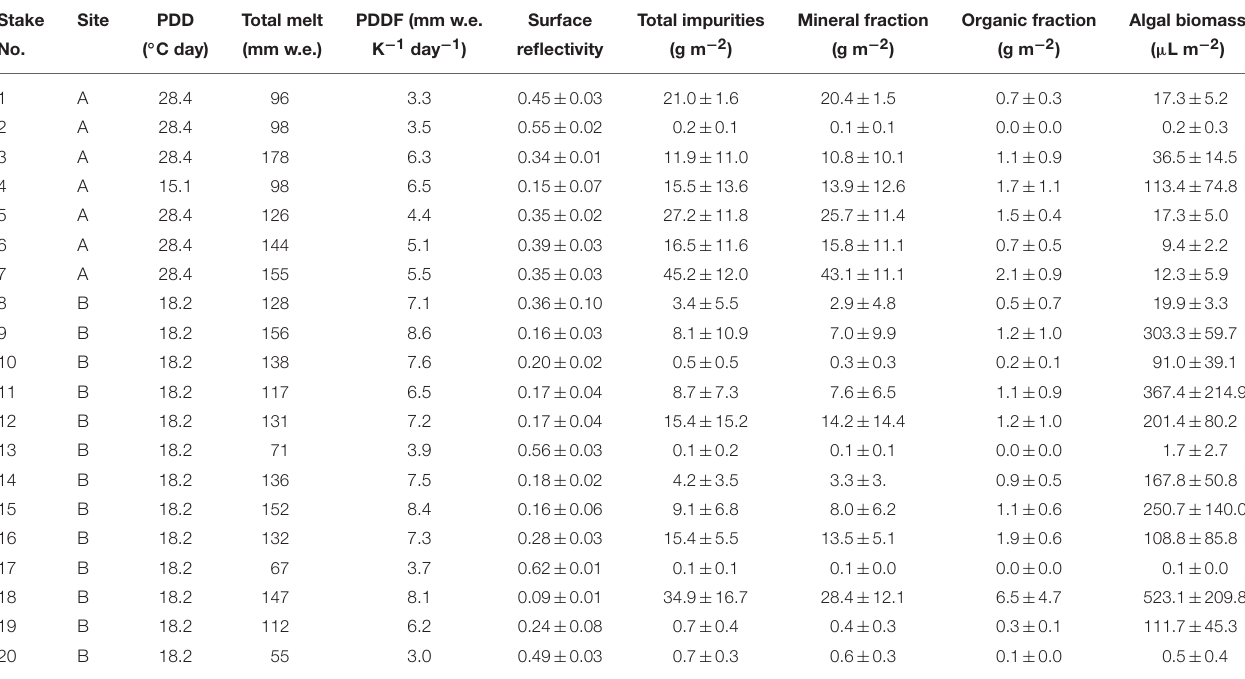
TABLE 1 | Results of measurements of PDDF, reflectivity, mass abundances of total and each fraction of impurities, and algal biomass at 20 stakes of sites A (2158 m) and B (2354 m) on the Glacier No. 31. Stake Site PDD Total melt PDDF (mm w.e.